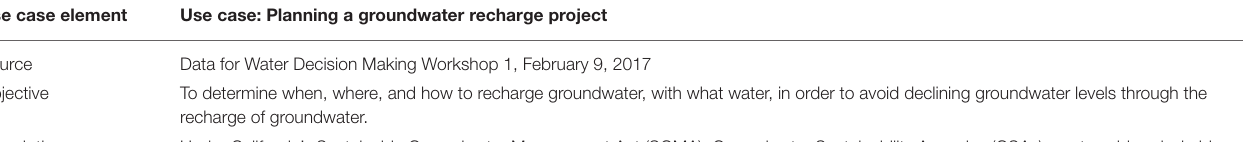
TABLE 2 | Example of completed use case: Groundwater recharge project